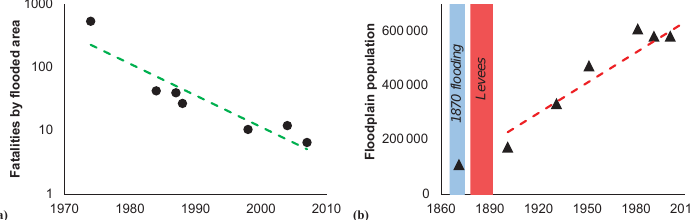
Figure 2. Examples of learning and forgetting effects. (a) Decreasing flood fatalities normalized by flooded area in Bangladesh (data from Mechler and Bouwer, 2015). (b) Increasing population in flood-prone areas in Rome (Italy), following a prolonged absence of flooding due to the construction of levees (data from Ciullo et al.,